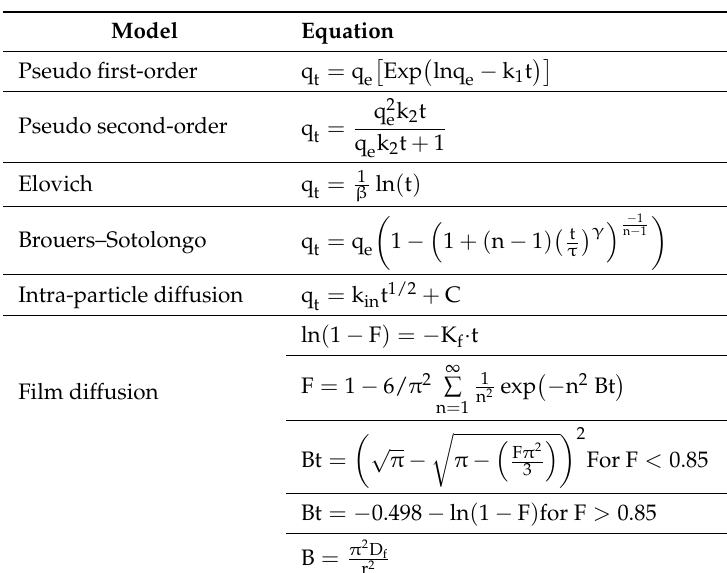
Table 3. Kinetic Models.